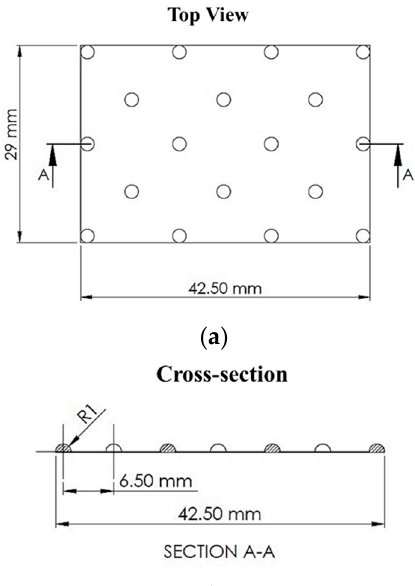
Figure 1. Plate and frame draw spacer used in experimental tests and ANSYS Fluent v19.1 analysis: ( a ) geometric view cut-out and ( b ) cross-section.